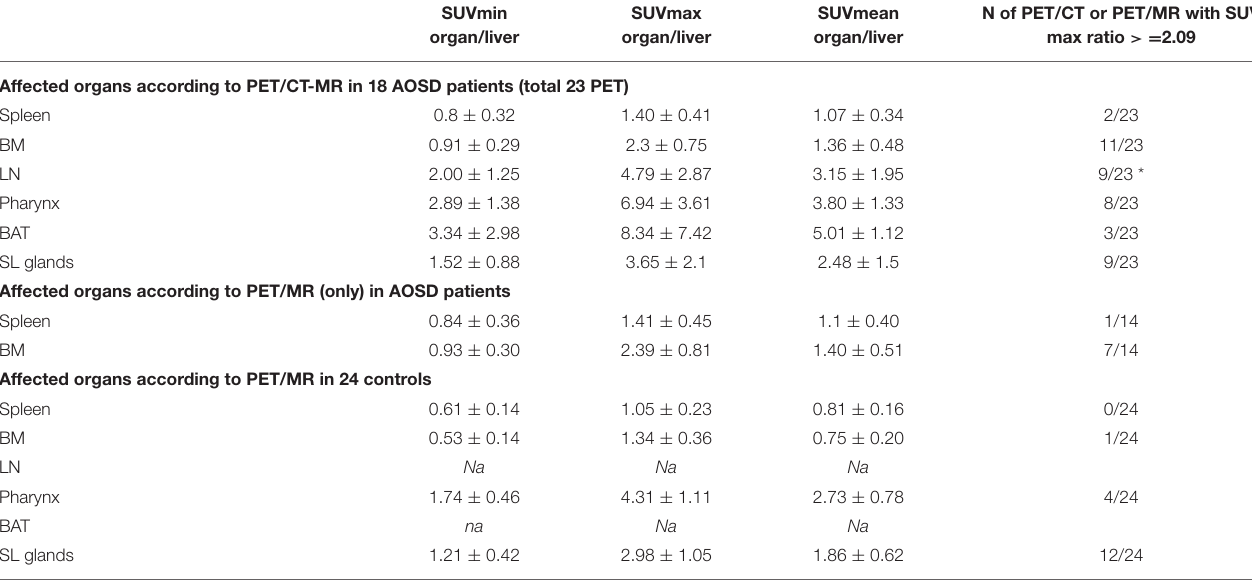
SUVmin SUVmax SUVmean N of PET/CT or PET/MR with SUV organ/liver organ/liver organ/liver max ratio > = 2.09